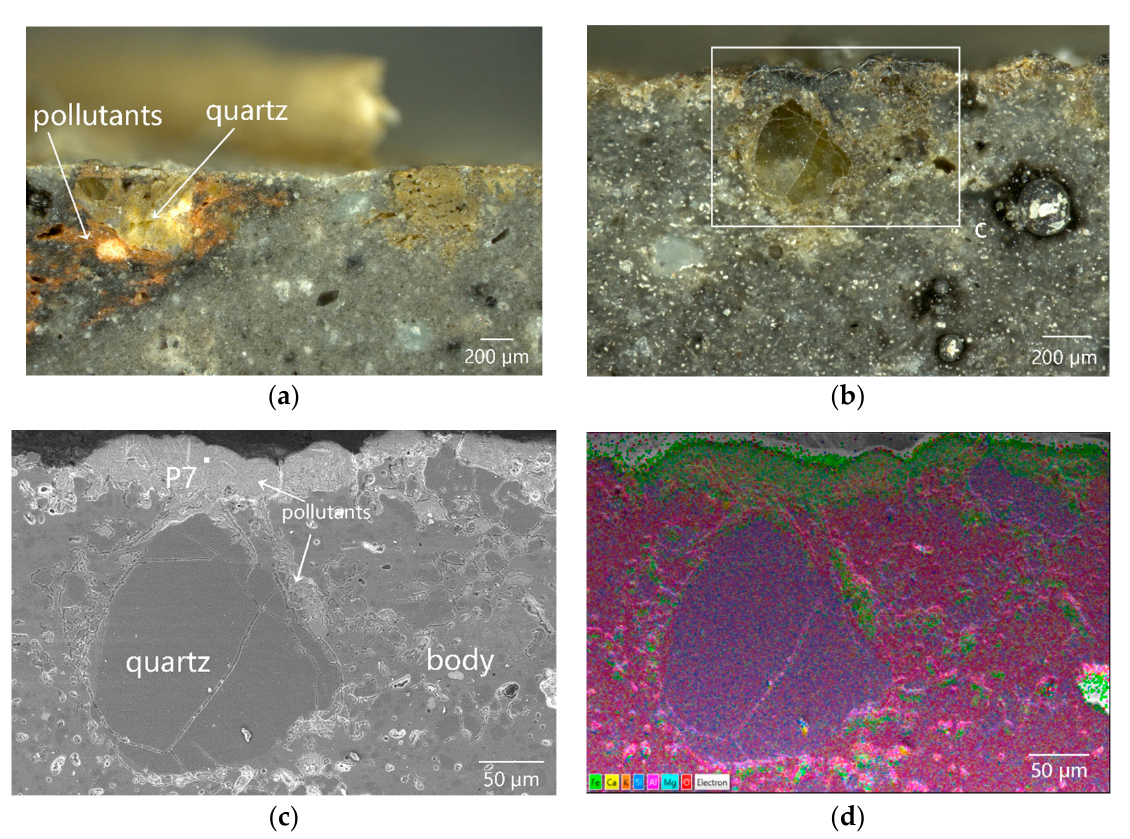
Figure 5. Cross-sectional morphology of sample DL-3: ( a , b ) OM images of quartz particles exposed